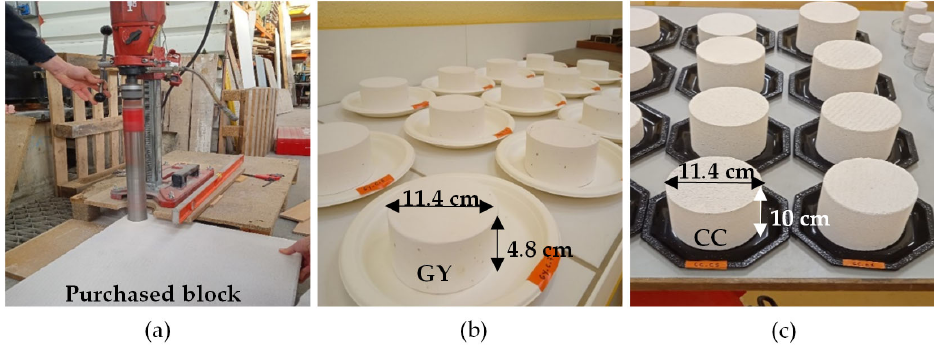
Table 2. Progress of the experimental